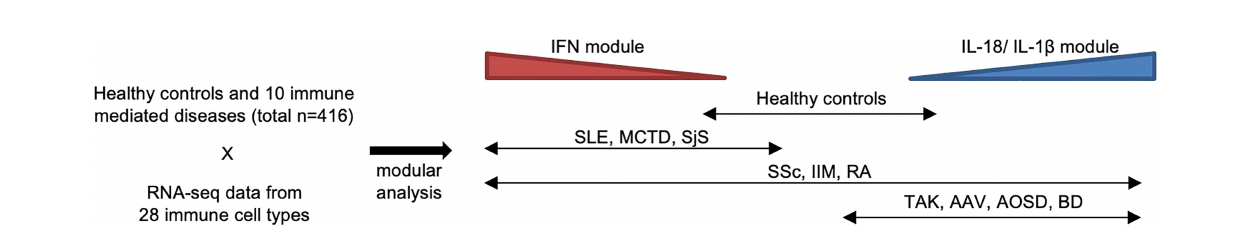
FIGURE 1 | Heterogeneity of immune-mediated diseases in ImmuNexUT. In the ImmuNexUT fl agship article, we applied weighted gene correlation network analysis (26) to immune cell gene expression data and systemically characterized the gene modules related to immune-mediated diseases. When we compared the expression of these modules between autoimmune disease patients and healthy controls, gene modules enriched with IFN-induced gene sets were overexpressed in autoimmune disease patients. SLE, mixed connective tissue disease (MCTD), Sjögren ’ s syndrome (SjS), systemic sclerosis (SSc), idiopathic in fl ammatory myopathy (IIM), and rheumatoid arthritis (RA). Gene modules enriched with IL-18 or IL-1 b -induced gene sets were overexpressed in patients with autoin fl ammatory diseases: Behc ̧ et ’ s disease (BD) and adult-onset Still ’ s disease (AOSD). Takayasu arteritis (TAK) or ANCA-associated vasculitis (AAV) patients showed similar expression patterns to those in autoin fl ammatory disease patients. SSc, IIM, and RA patients were more heterogeneous compared with the